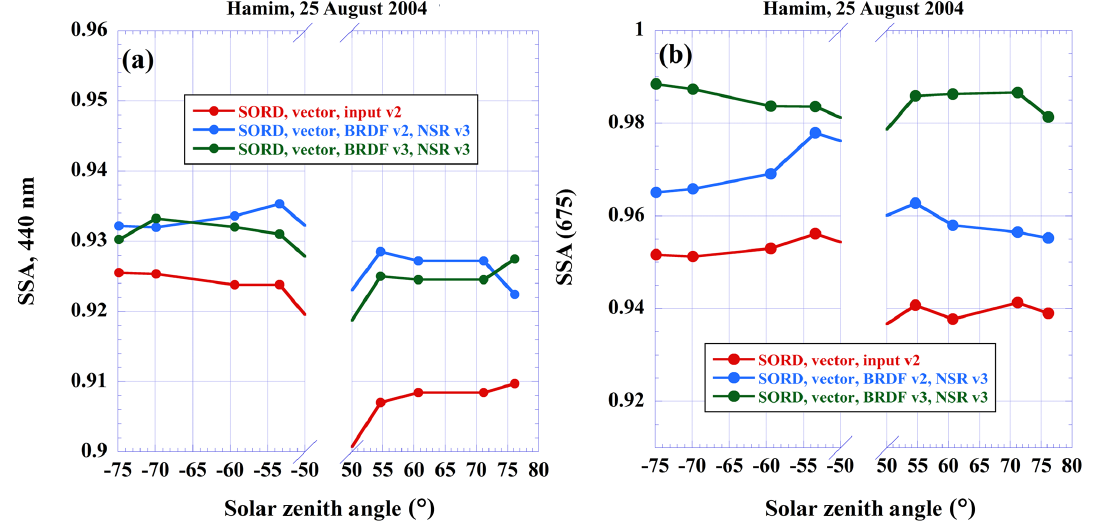
Figure 9. Hamim on 25 August 2004. The diurnal variability of Level 2 SSA retrievals at 440nm for three combinations of SORD and inversion inputs: V2 inputs (red), combined inputs with BRDF parameters of V2 and NSR of V3 (blue), and combined inputs with BRDF parameters of V3 and NSR of V3 (green) for (a) 440nm and (b) 675nm.